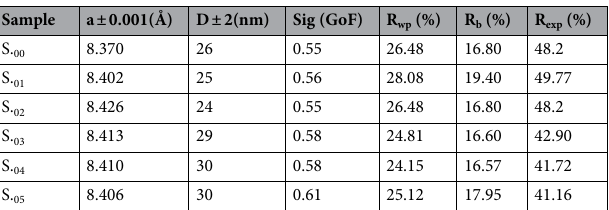
Table 1. The lattice constants, the mean crystallite sizes and Rietveld-refined XRD data of the as-prepared Sm 3+ substituted nanoparticles.